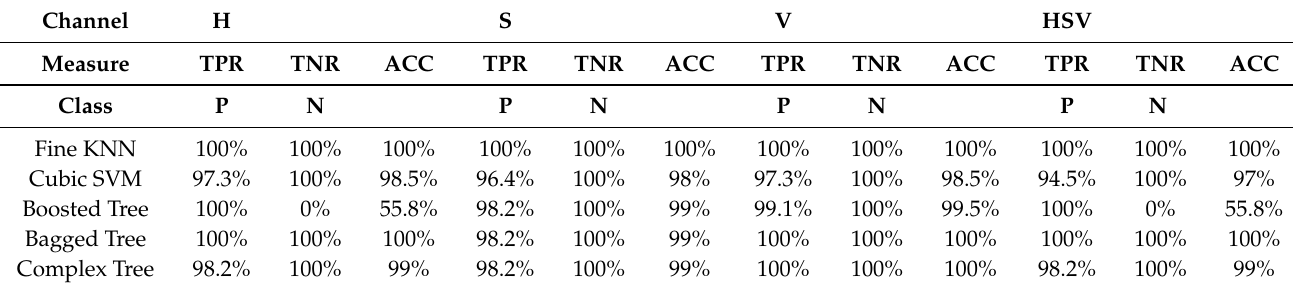
Bagged Tree Complex Tree Table 6. Combined results obtained using HSV histogram features for image-level classification. Channel